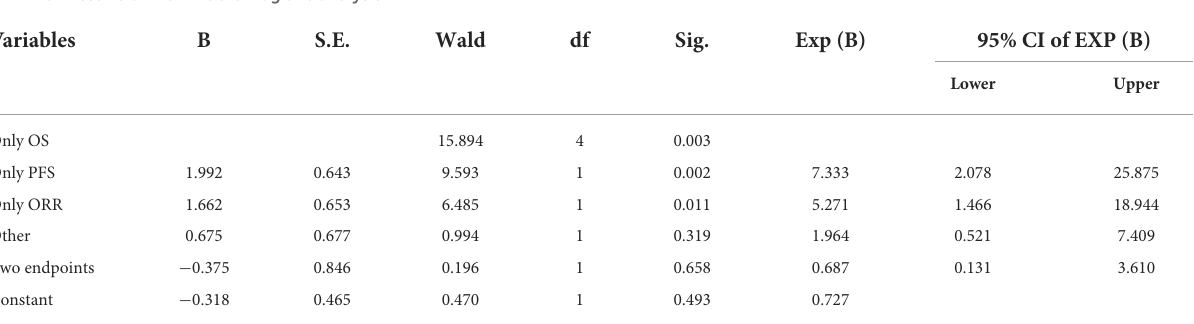
TABLE 3 Results of multi-factor logistic